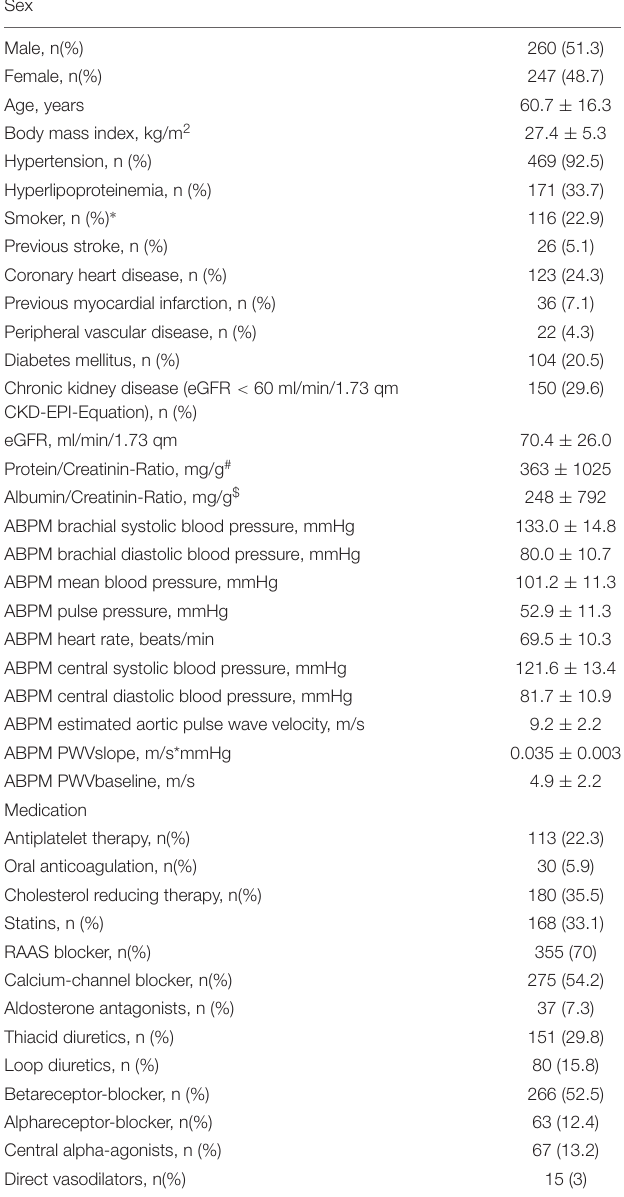
TABLE 1 | Main characteristics and medication of the study collective ( n = 507).